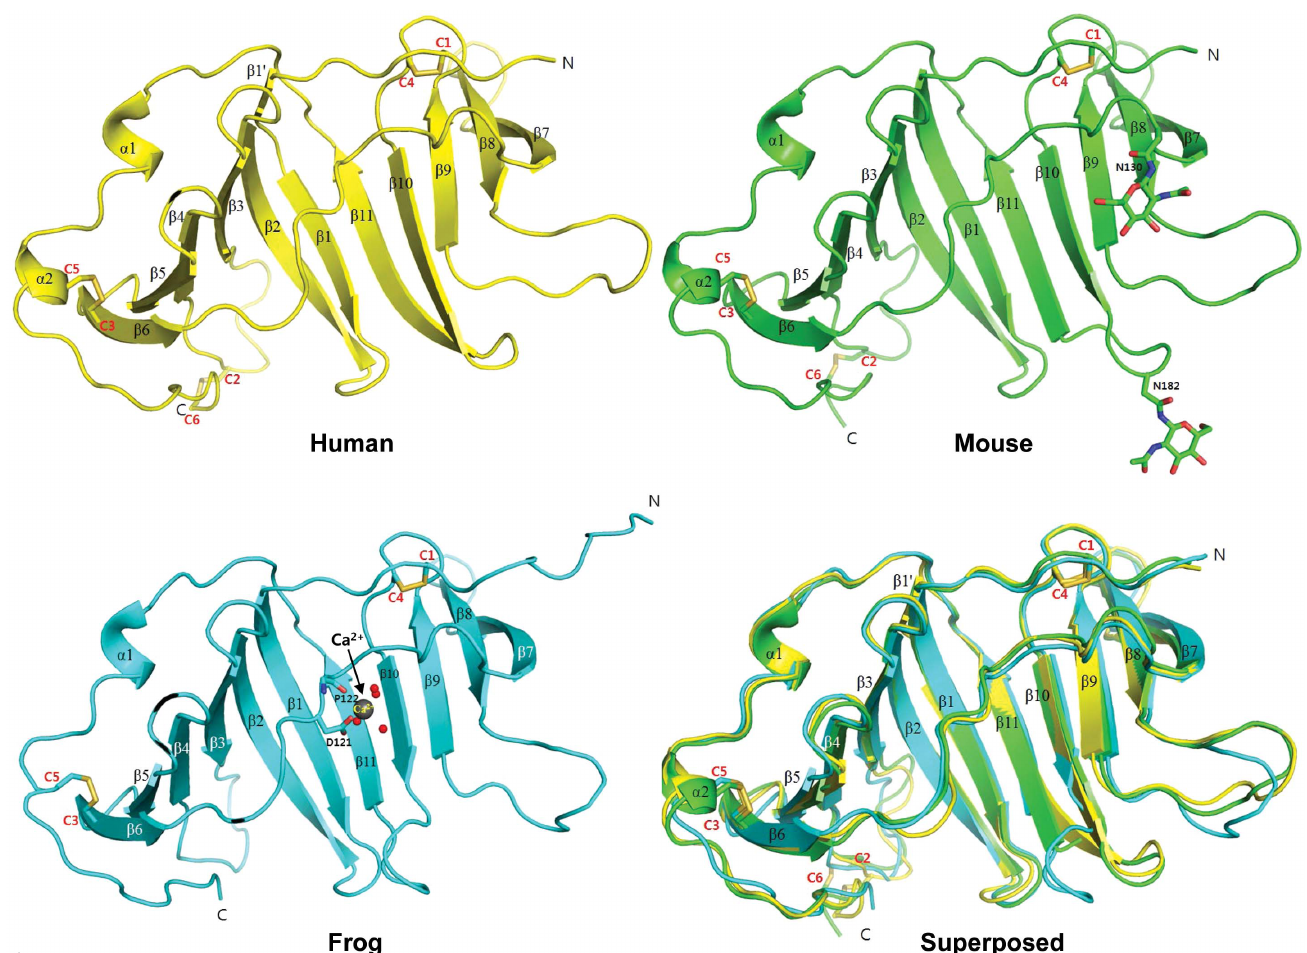
Figure 1 The overall structures of human, mouse and frog EPDR1. A ribbon diagram of human EPDR1 is shown (in yellow) with secondary-structure elements indicated. The locations of cysteines (C1–C6) and the disulfide bonds are also shown. A ribbon diagram of mouse EPDR1 is shown (in green) with two asparagine residues and their NAG glycosylation shown as stick models. Although other types of glycosylation were observed at Asn182, only NAG is shown for clarity (see Fig. 3 for more on glycosylation). A ribbon diagram of frog EPDR1 is shown (in blue) with Ca 2+ ions (shown as spheres), four Ca 2+ - binding waters (shown as spheres) and direct Ca 2+ -interacting residues (shown in stick representation). The details of the interaction network stabilizing the bound Ca 2+ ions in frog EPDR1 are shown in Fig. 3( c ). Note that the same colors will be used throughout the figures. The superposed structures of the three EPDR1s are also shown. The superimposed EPDR1 structures show C (cid:4) r.m.s.d.s of 0.8 A˚ (human versus mouse), 1.1 A˚ (human versus frog) and 1.1 A˚ (mouse versus